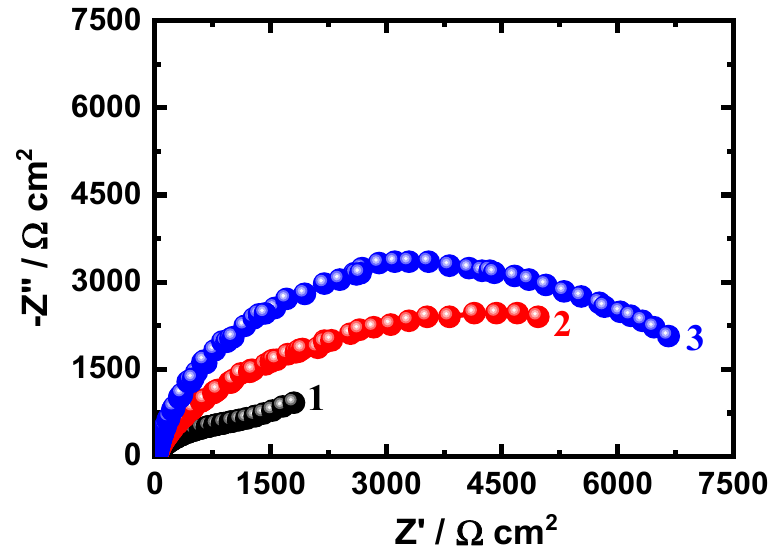
Figure 8. Nyquist plots obtained for (1) first Al-SiC nanocomposite, (2) second Al-SiC nanocomposite and (3) third Al-SiC nanocomposite after their immersion in 3.5% NaCl solutions for 48 h.